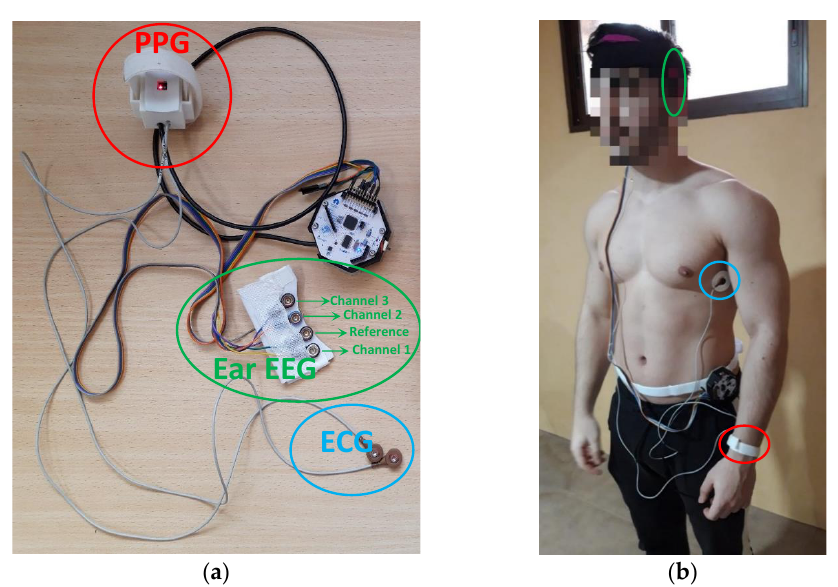
Figure 2. ( a ) Components of the ambulatory monitoring system. Ear EEG is composed of flexible gold cup electrodes (three channels + one reference and noise-canceling); ( b ) Placement of each of the elements that make up the ambulatory monitoring system on the user. Electrodes were placed on both sides of the chest in order to hold the device as tightly as possible and improve comfort. Table 1. Information about the